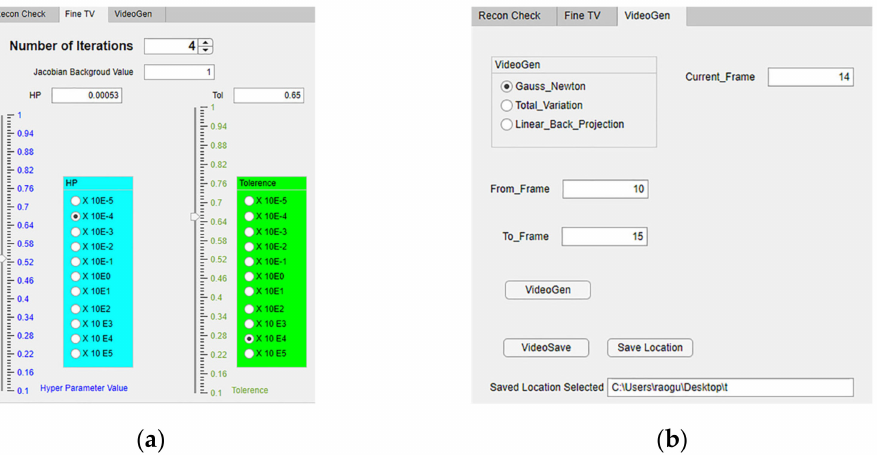
Figure 8. ( a ) Reconstruction module: Total Variation algorithm tab (selecting reconstruction parameter value progression from coarse to fine/detailed); ( b ) VideoGen function in